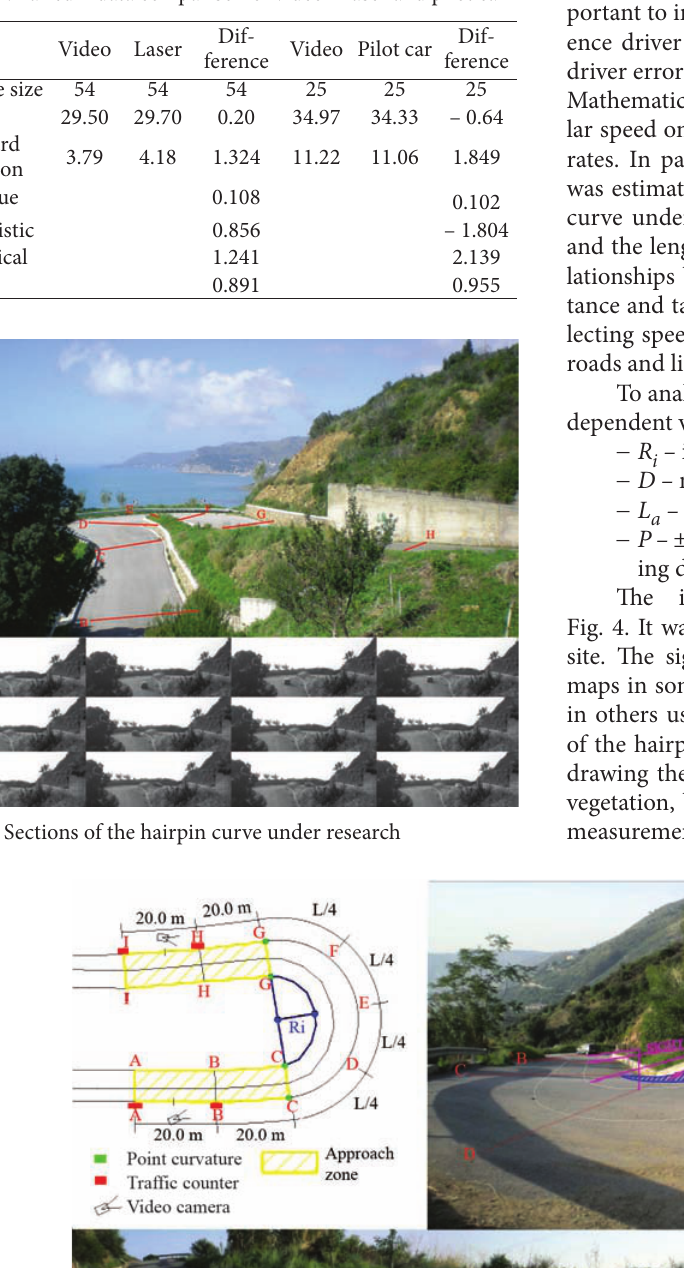
Table 2. Paired – data comparison of video – laser and pilot car